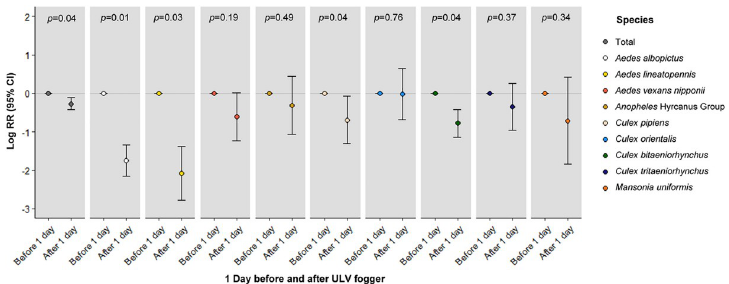
Fig 4. Comparison the mean numbers (range) of mosquitoes collected daily using Mosquito Magnet 1 traps operated at 12 collection sites at USAG Humphreys 1 day before and the following day after pesticide application using an ULV fogger during 2018. Anopheles Hyrcanus Group includes An . sinensis s.s., An . belenrae , An . lesteri , An . kleini , and An . pullus that cannot be identified by morphological techniques. � Adjusted for a lag of 2-weeks compared to daily mean temperatures and cumulative precipitation, season. RR, relative risk; CI, confidence interval.